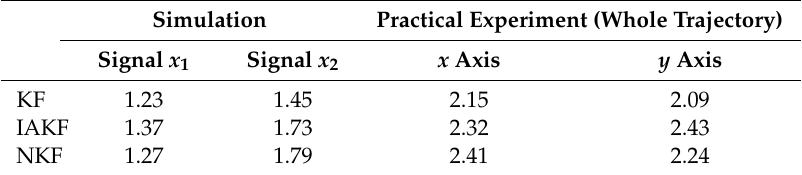
Table 4. Operation time of di ff erent methods in simulation and experiment (time unit: